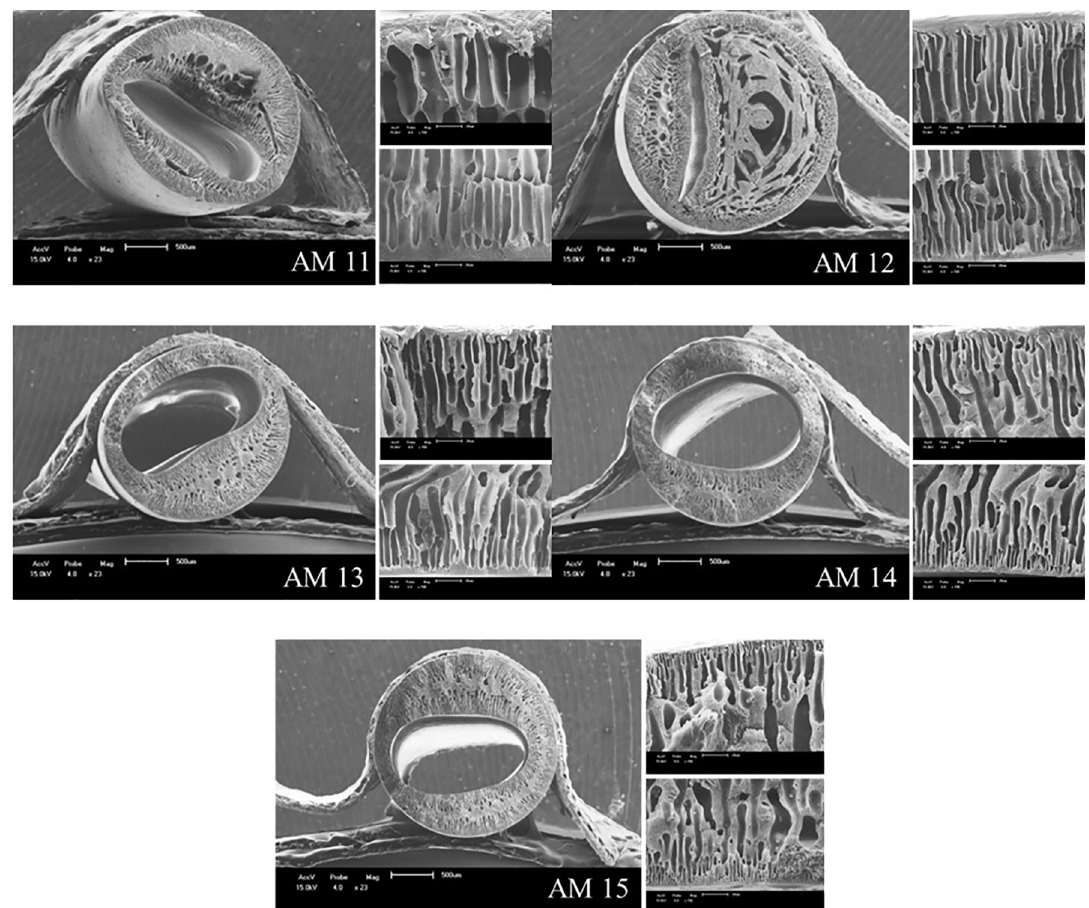
Figure 5. SEM Images of PES hollow fiber membranes with the PVP (9 wt%, 7 wt%, 5 wt%, 3 wt% and 1 wt%) and clay (1 wt%, 3 wt%, 5 wt%, 7 wt% and